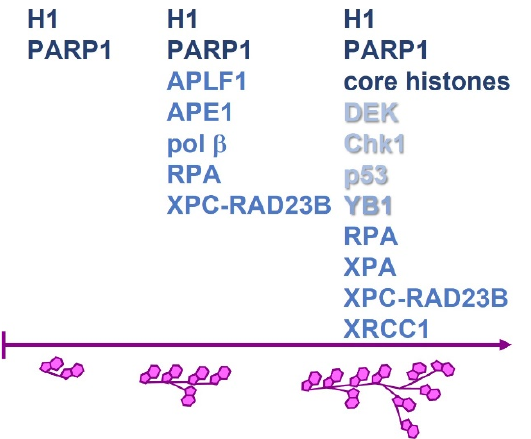
Figure 6. Affinity of various proteins towards different PAR chains. ADP-ribose units are represented by a magenta double-polygon. An increase in length and the number of branch points in the polymer correlated with the number of ADP-ribose units.